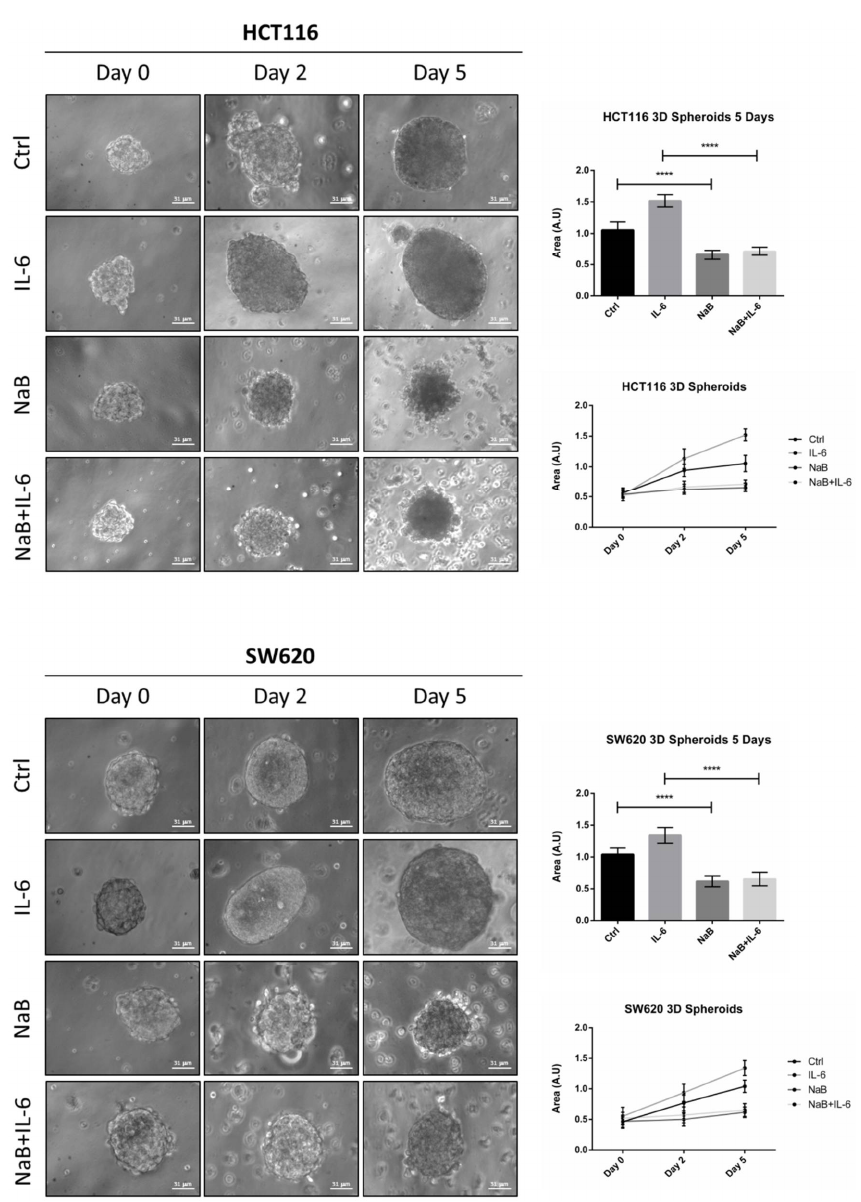
Figure 2. Sodium butyrate reduces the growth of 3D CRC spheroids. HCT116 and SW620 cells growing in suspension in polyhema-coated petri dishes were treated with 1 mM NaB and 50 ng/mL interleukine-6 (IL-6), alone or in combination. Medium and substances were replaced every 48 h. The growth of spheroids was monitored by taking pictures with a phase contrast microscope up to 5 days (scale bar = 31 m). Images representative of each condition are shown. The graphs represent the average area ± SD (significance was considered as follow: **** p < 0.0001).